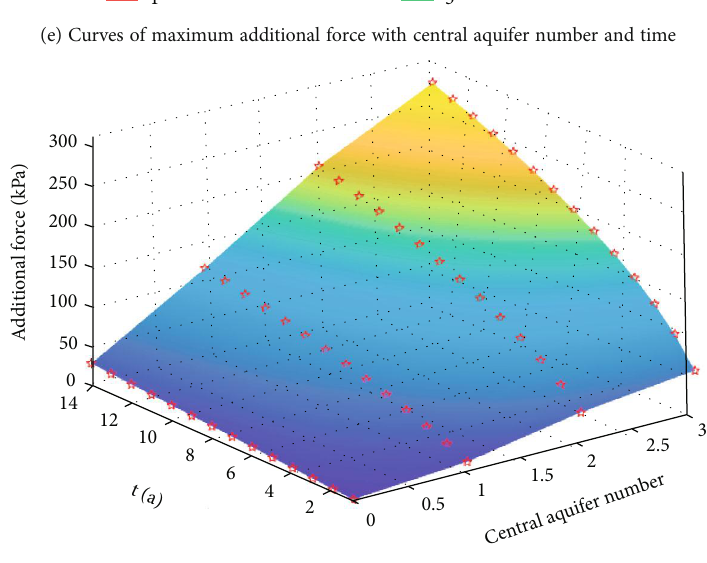
Figure 13: Relationship between the additional force and central aquifer